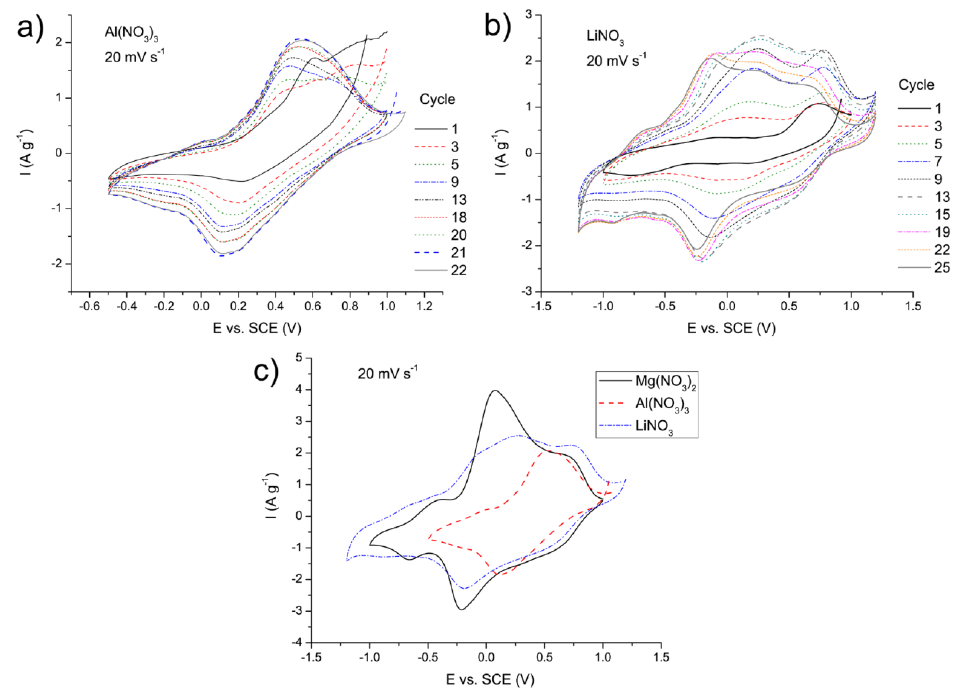
Figure 12. Cyclic voltammograms of the MgVO/C recorded at 20 mVs −1 in 1M Al(NO 3 ) 3 ( a ) and 6M LiNO 3 ( b ), showing together the highest currents achieved in three different media (Mg, Al, and Li nitrate) ( c ).